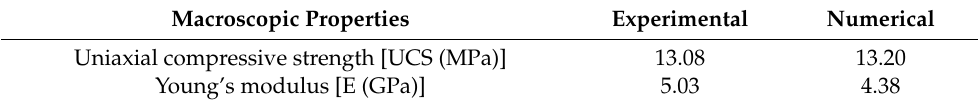
Table 4. Comparisons of the experimentally and numerically calibrated macroscopic properties.